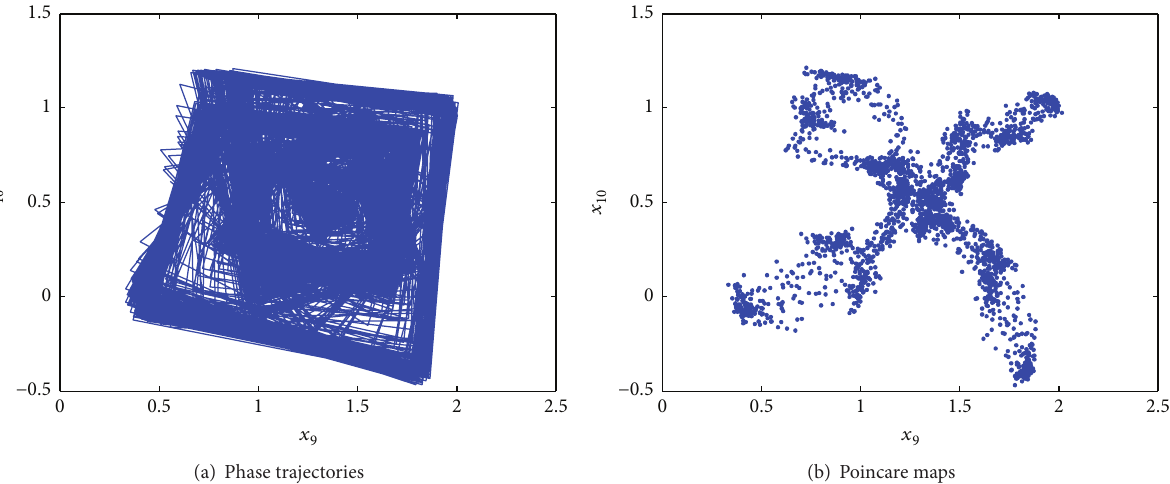
Figure 11: 𝜔 = 175 with random perturbation.